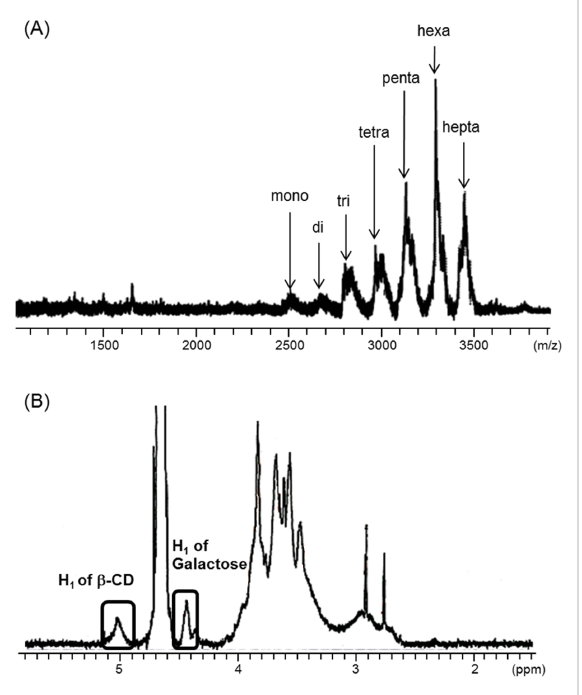
Figure 2: MALDI–TOFMS (A) and 1 H NMR spectra (B) of multi-Lac- β - CD (DSL5.6)